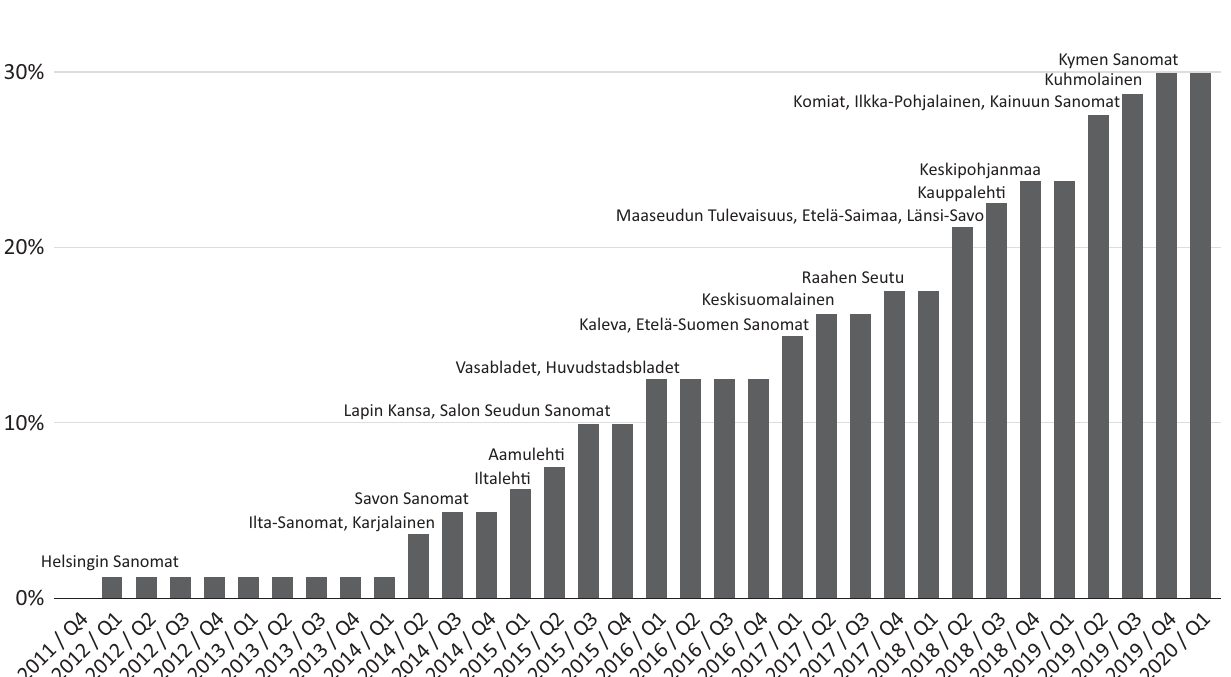
Figure 1. Share of drones and time of acquisition among Finland’s 80 leading newspapers,